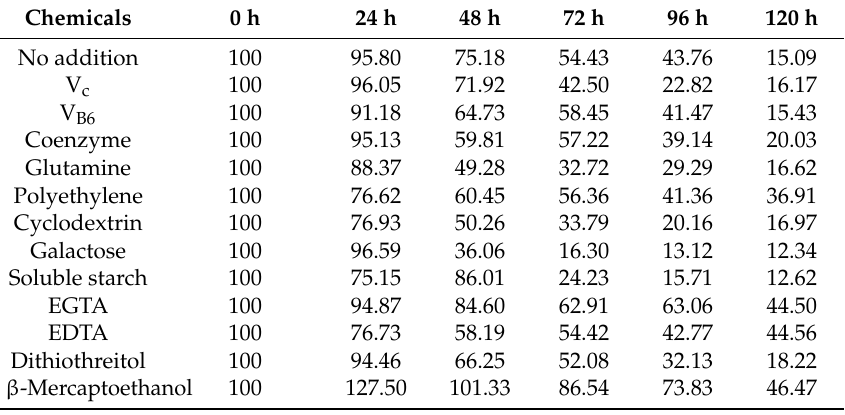
Figure 6. Effects of metal ion on the activity of chitinase from C. meiyuanensis SYBC-H1. Table 3. Effects of various reagents on CHI2 chitinase with colloidal chitin as the substrate.